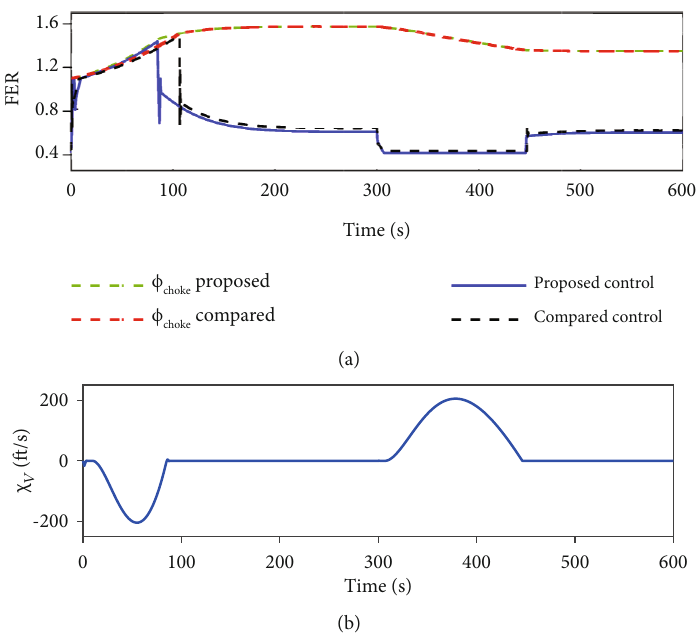
Figure 5: FER and state of the auxiliary system χ